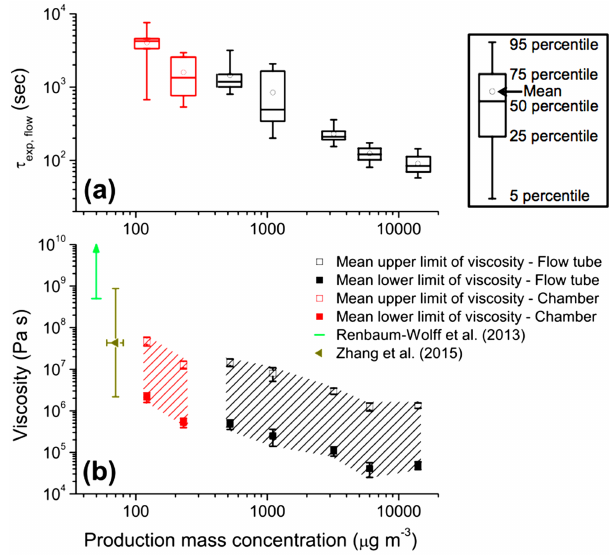
Figure 5. Summary of poke-and-flow experiments performed on samples of whole SOM at <0.5% RH. Black symbols represent re- sults from particles produced in a flow tube, whilst red symbols rep- resent results from particles produced in a chamber. Panel (a) shows box plots of observed τ exp, flow times at different production mass concentrations for particles poked <0.5% RH. Boxes represent the 25, 50, and 75 percentiles, open circles represent median values, and whiskers represent the 5 and 95 percentiles. Panel (b) shows the simulated lower (filled squares) and upper (open squares) limit of viscosity for particles at each production mass concentration poked at <0.5%. Symbols represent mean values. The y error bars rep- resent 95% confidence intervals. The shaded regions are included to guide the eye of the reader. Also included in (b) are litera- ture viscosities for SOM produced via the ozonolysis of α -pinene (Renbaum-Wolff et al., 2013; Zhang et al.,